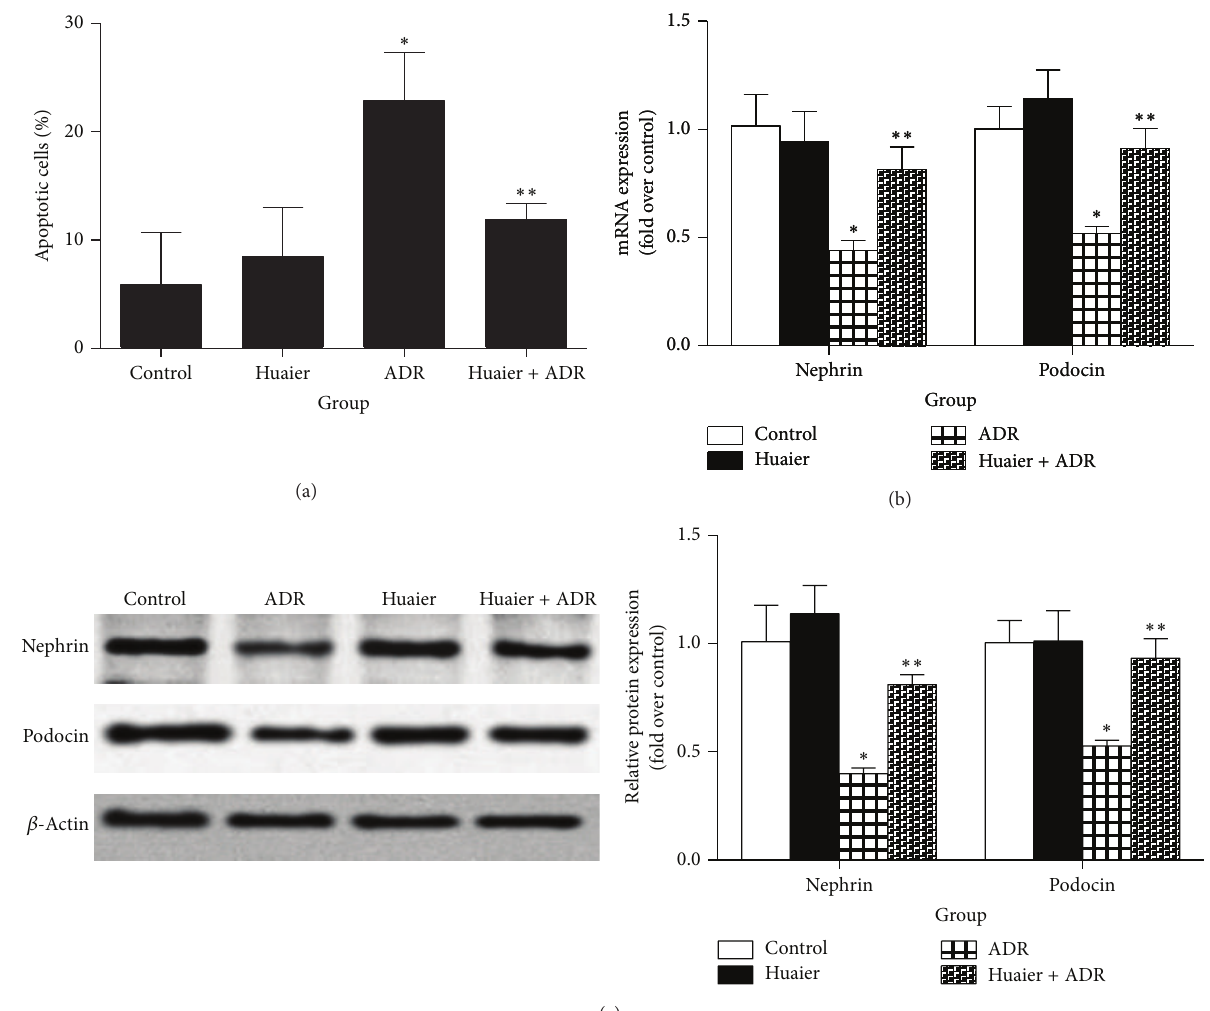
Figure 1: Huaier protected podocytes against ADR-induced injury in vitro . (a) Percentage of apoptotic cells. (b) Real-time RT-PCR of nephrin and podocin. (c) Western blot of nephrin and podocin. Left: representative immunoblots. Right: densitometric analysis. Podocytes were pretreated with Huaier (0.2mg/mL) for 1h followed by incubation with ADR (200 nM) for further 48 h (for apoptosis analysis, (a)) or 24 h (for real-time RT-PCR analysis (b); immunoblotting analysis (c)). Data are expressed as the means ± SD ( 𝑛 = 6 ). ∗ 𝑃 < 0.05 versus control. ∗∗ 𝑃 < 0.05 versus ADR